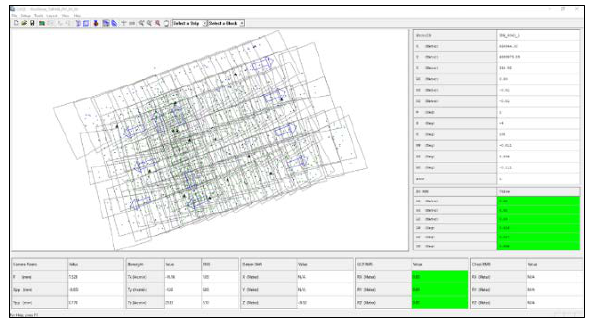
Figure 6: CalQC project for Calibration